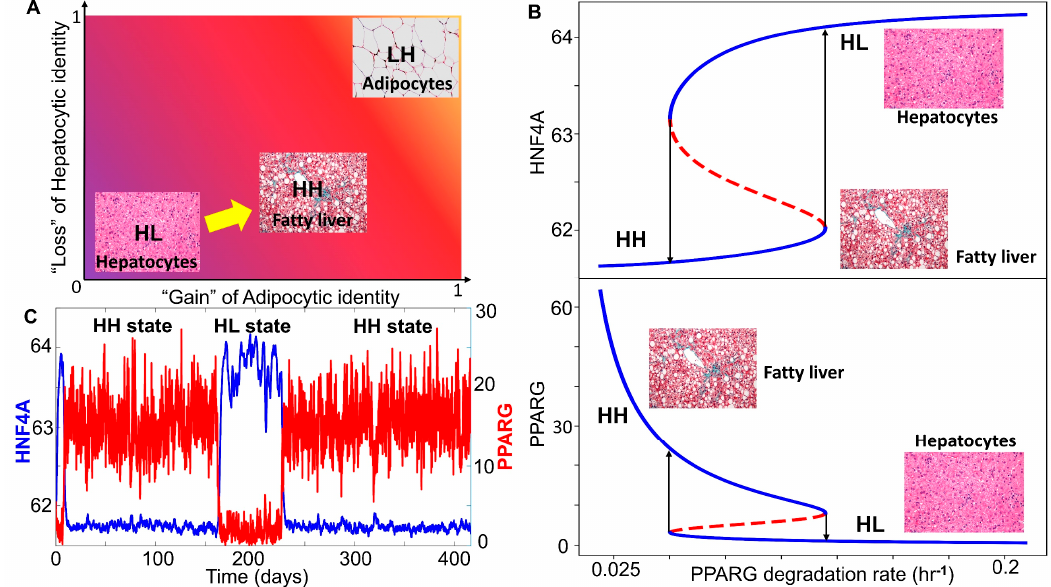
Figure 4. NAFLD as a bistable system involving a phenotypic switch from a hepatocyte to a “hybrid” adipocyte-like phenotype of the hepatocytes. (A) Schematic showing the phenotypic transition that may happen in the context of NAFLD where the disease can be highly diverse in terms of the extent of loss of hepatocytic and/or gain of adipocytic characteristics. (B) Bifurcation plots showing the phenotypic transitions, i.e., switch in the levels of HNF4A (top panel) and PPARG (bottom panel) when the degradation rate of PPARG is used as a bifurcation parameter. Solid blue lines denote the stable states, dotted red lines denote the unstable states of the system. Arrows indicate transitions between the two states. (C) Stochastic simulations of the core gene regulatory network showing switching in HNF4A and PPARG levels (degradation rate of PPARG = 0.08 hr -1 ). (Image credit for “hepatocyte”, “fatty liver”, “adipocytes” in A and B: Wikimedia Commons).